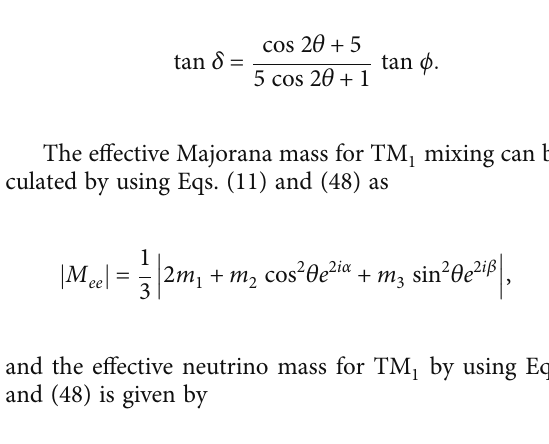
ν with TM 1 mixing at 3